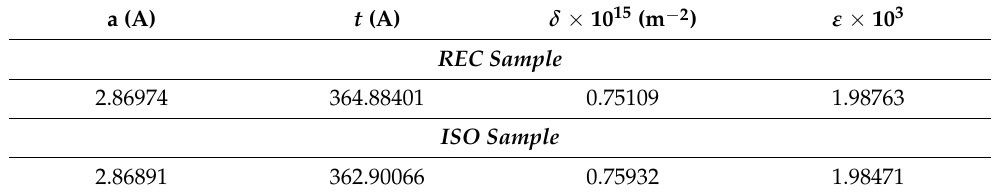
Table 6. Parameters obtained from refinement of the XRD analysis in the heat-treated